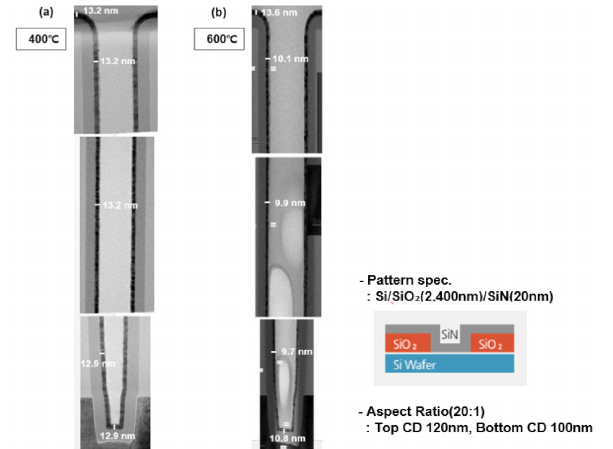
Figure 8. Step coverage characteristics in patterns based on deposition temperature: ( a ) 400 ◦ C, ( b ) 600 ◦ C.